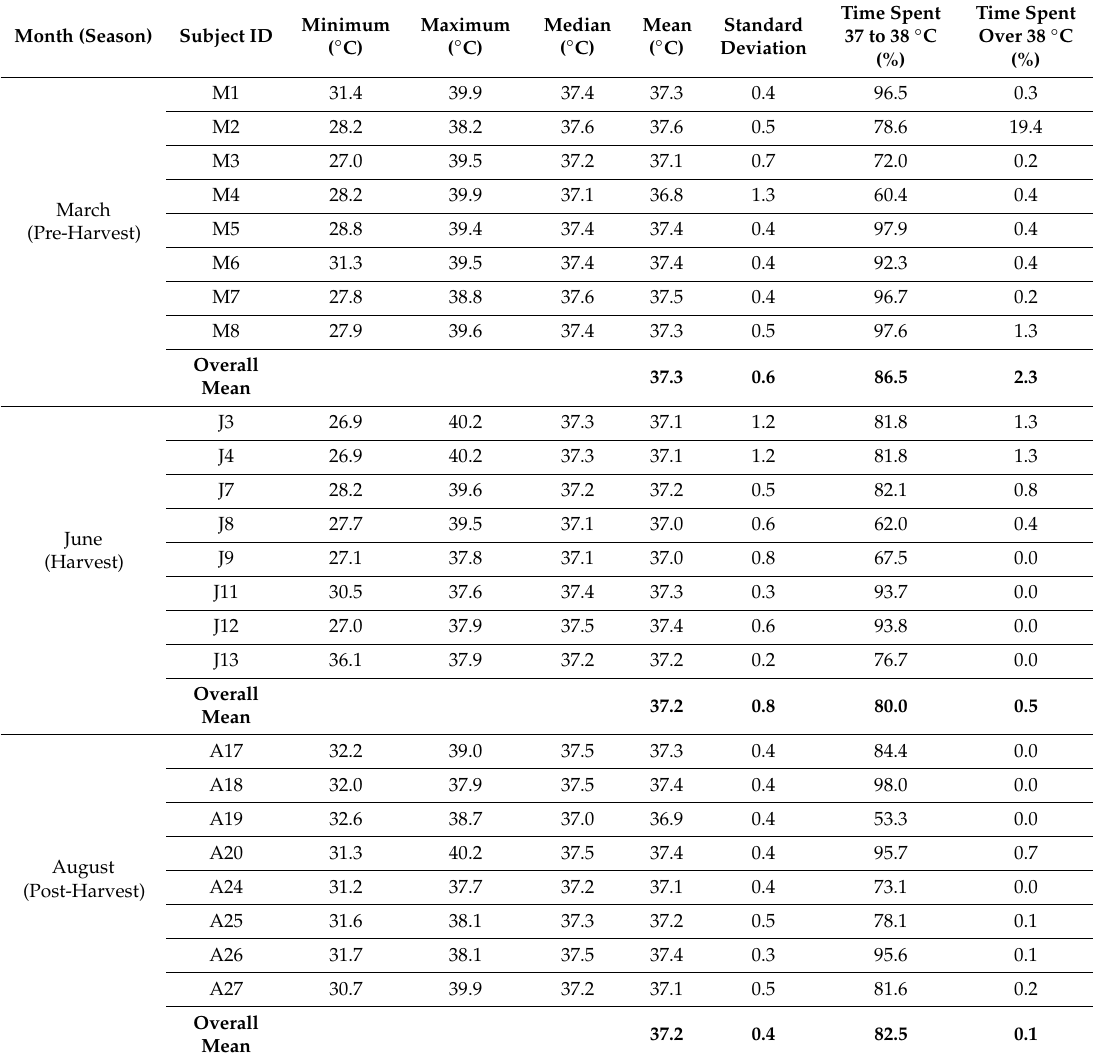
Table 3. Core body temperature by participant and month, n =